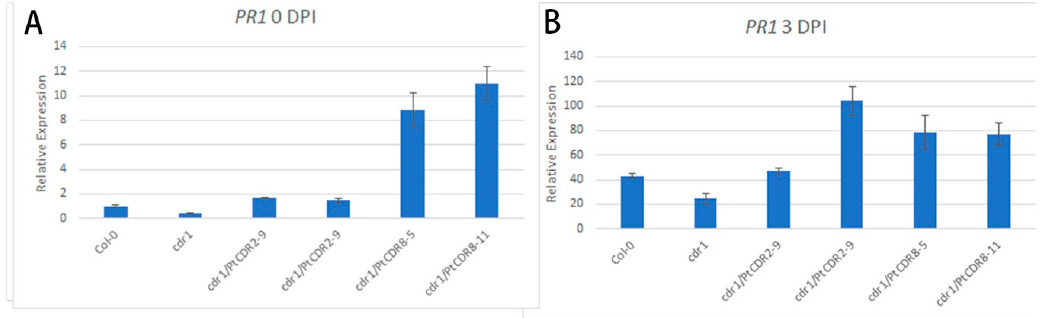
Figure 4. Relative expression of PR1 in wild ‐ type Arabidopsis (Col ‐ 0), its cdr1 mutant (cdr1), and four transgenic lines (cdr1/PtCDR2 ‐ 6, cdr1/PtCDR2 ‐ 9, cdr1/PtCDR8 ‐ 5, and cdr1/PtCDR8 ‐ 11).